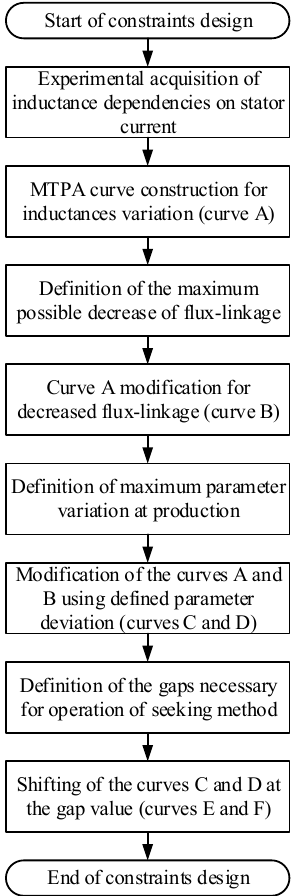
Figure 9. Flowchart of constraints design algorithm.